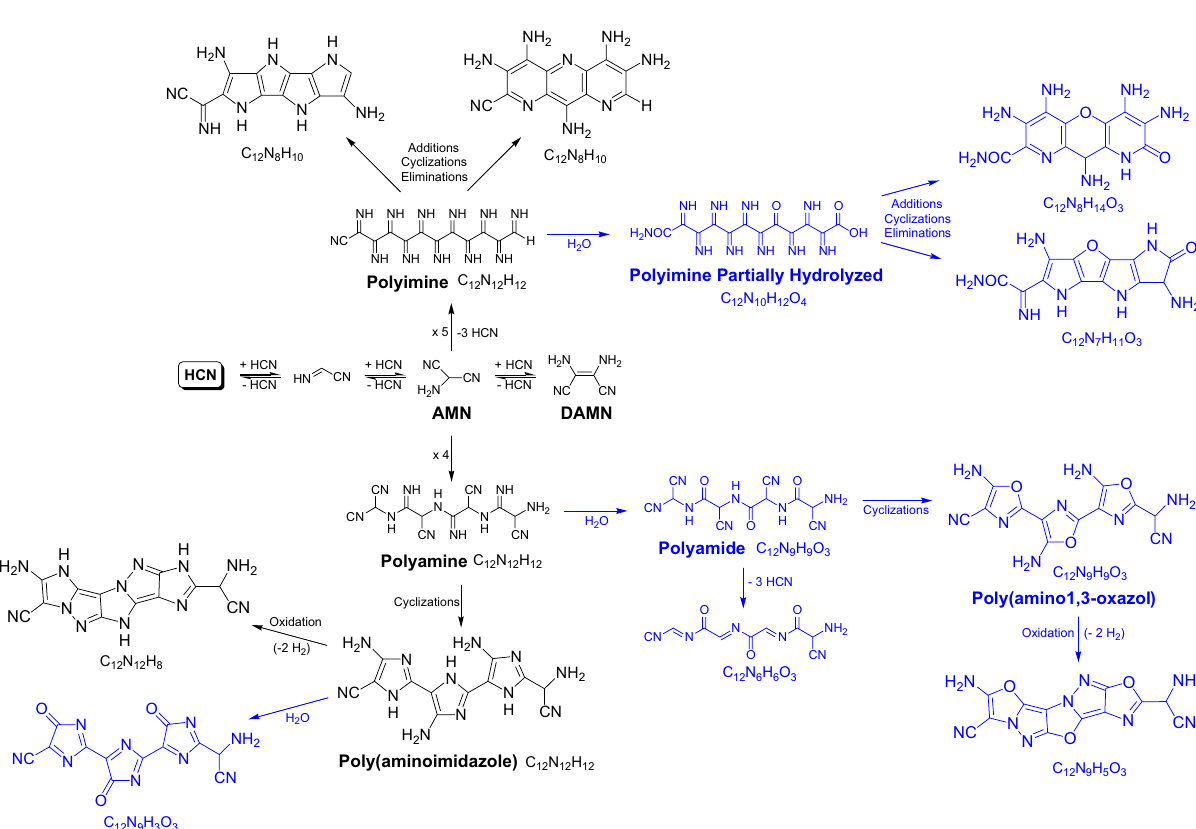
Scheme 1. Pathways for the formation of NH 4 CN polymers from AMN according to recent studies in the literature 10,11